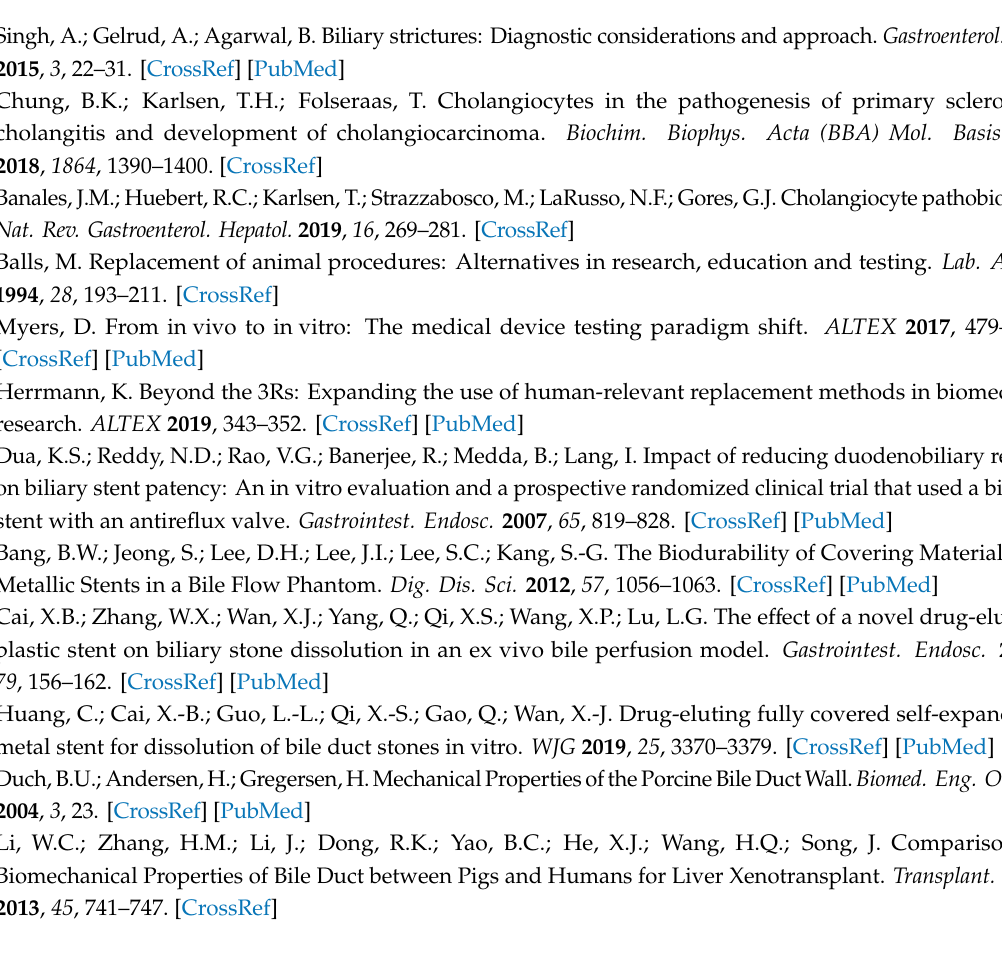
Figure S1: EHBD orientation on print platform. Samples were manually positioned at ~45 ◦ angle to the print platform to promote resin drainage between layers and minimize polymerization due to laser scatter. This angle also ensured the height of the support sca ff olding would not result in misprints, Figure S2: Transient increase in FE elasticity upon exposure to liquids. (A) Stress–strain analysis after 3 day liquid exposure. All samples exposed to liquids experienced a significant decrease in elastic modulus (see Figure 4). (B) Stress–strain analysis after 7 day liquid exposure. All increases in elasticity seen at three days were reversed after one week. Stress–strain curves represent the average values taken from N = 6 samples. See Section 3.3 for statistical analysis of the change